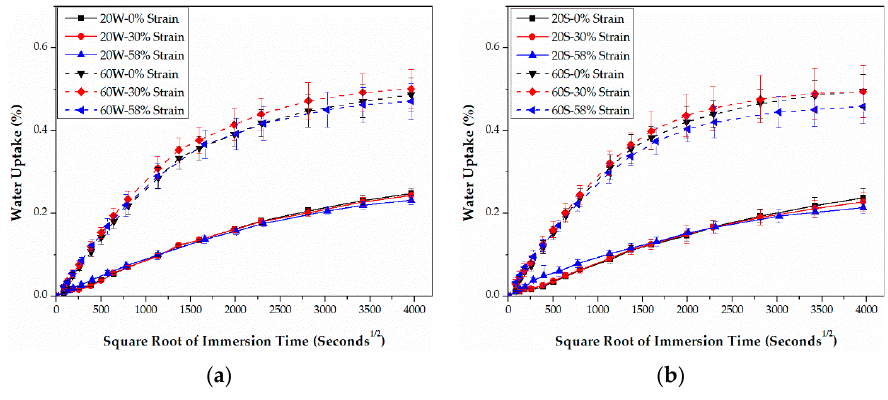
Figure 5. Water uptake curves of epoxy-based CFRPs immersed in distilled water ( a ) and seawater ( b ) for 6 months, respectively.